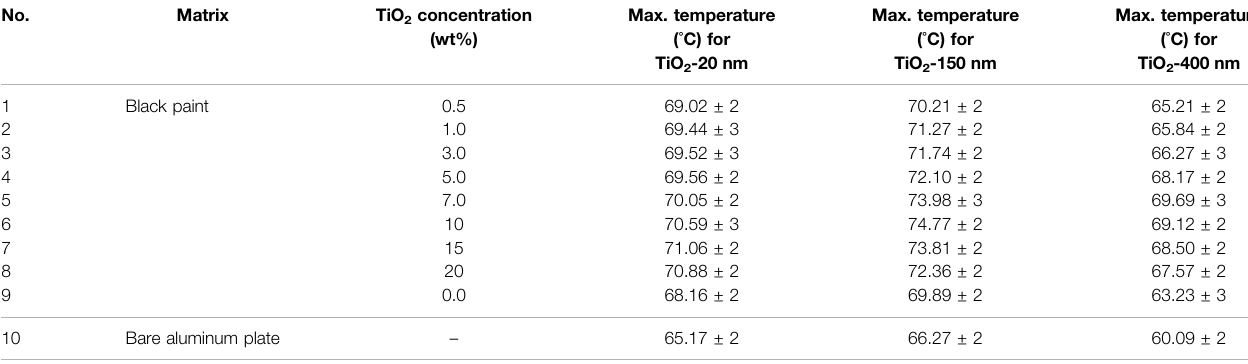
TABLE 2 | Summary of outdoor maximum temperature for TiO 2 -20 nm at 1,000 W/m 2 . No.